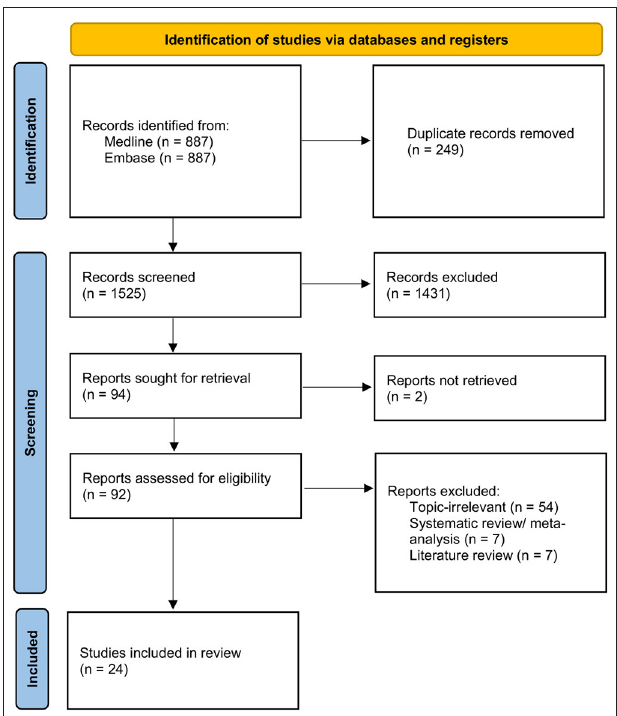
FIGURE 1 | PRISMA flowchart of included